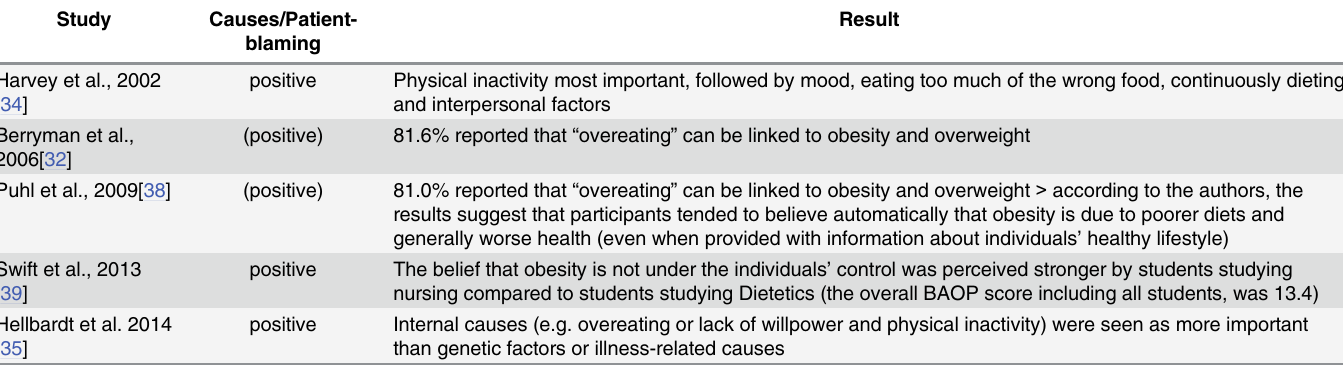
Table 4. Summary of studies examining the dietitians ’ believes about causes or controllability of obesity.